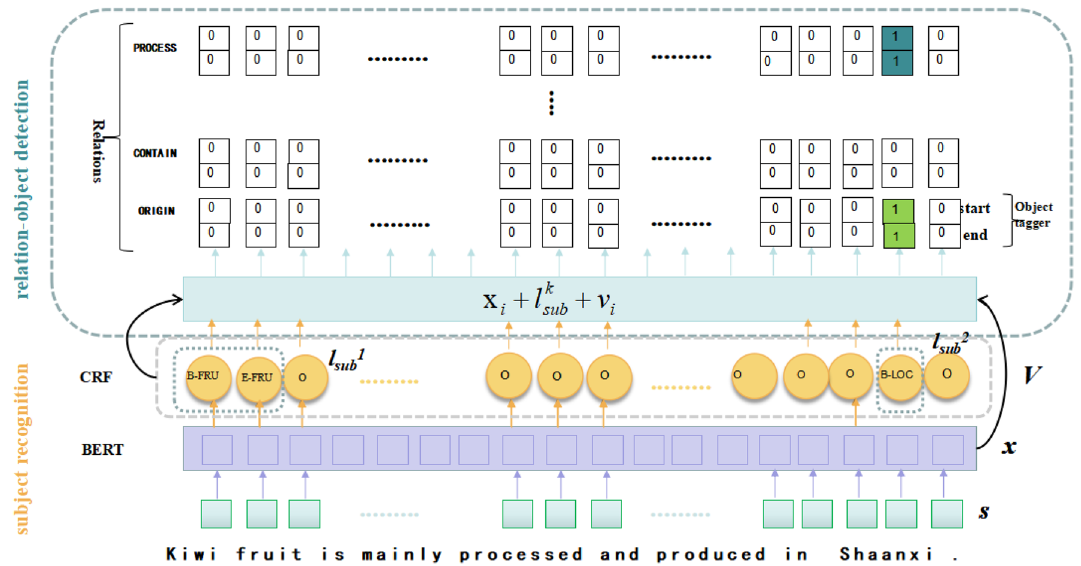
Figure 1. Subject-oriented overlapping triplets extraction model. This model takes the sentence “Kiwifruit is mainly processed and produced in Shaanxi.” as input, and the output triplets are (kiwifruit,origin,Shaanxi) and